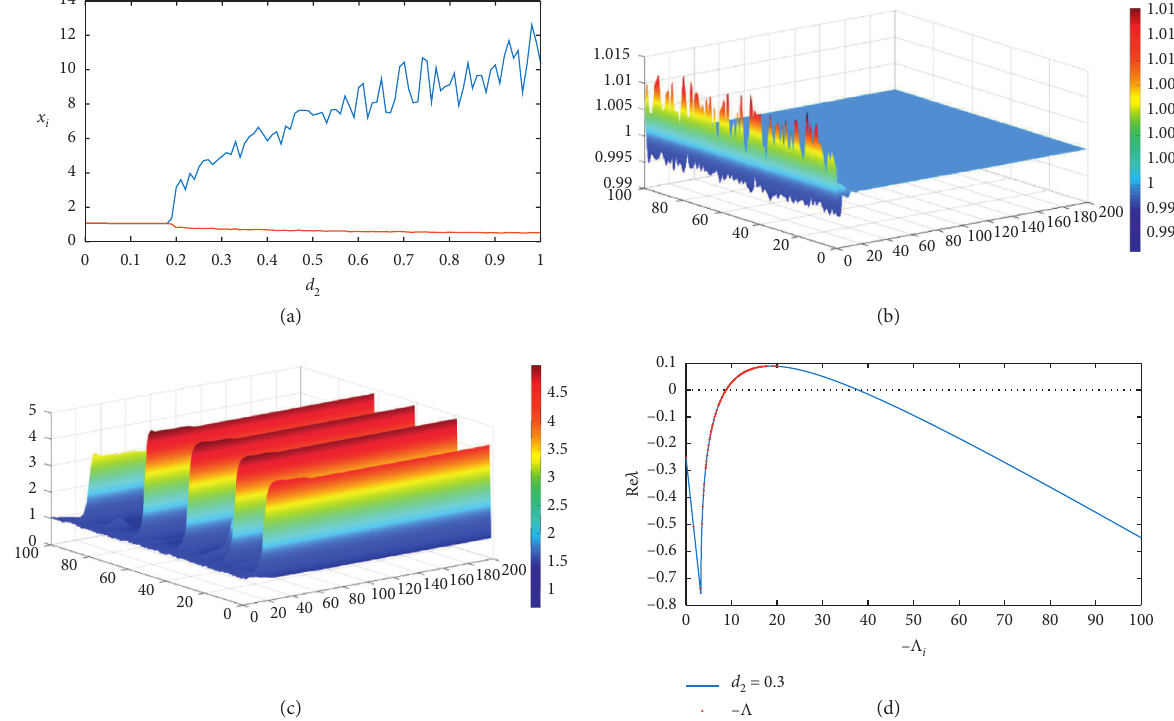
Figure 8: (a) The bifurcation diagram of d � 0 . 1. (c) Turing instability occurs when d d 2 system.